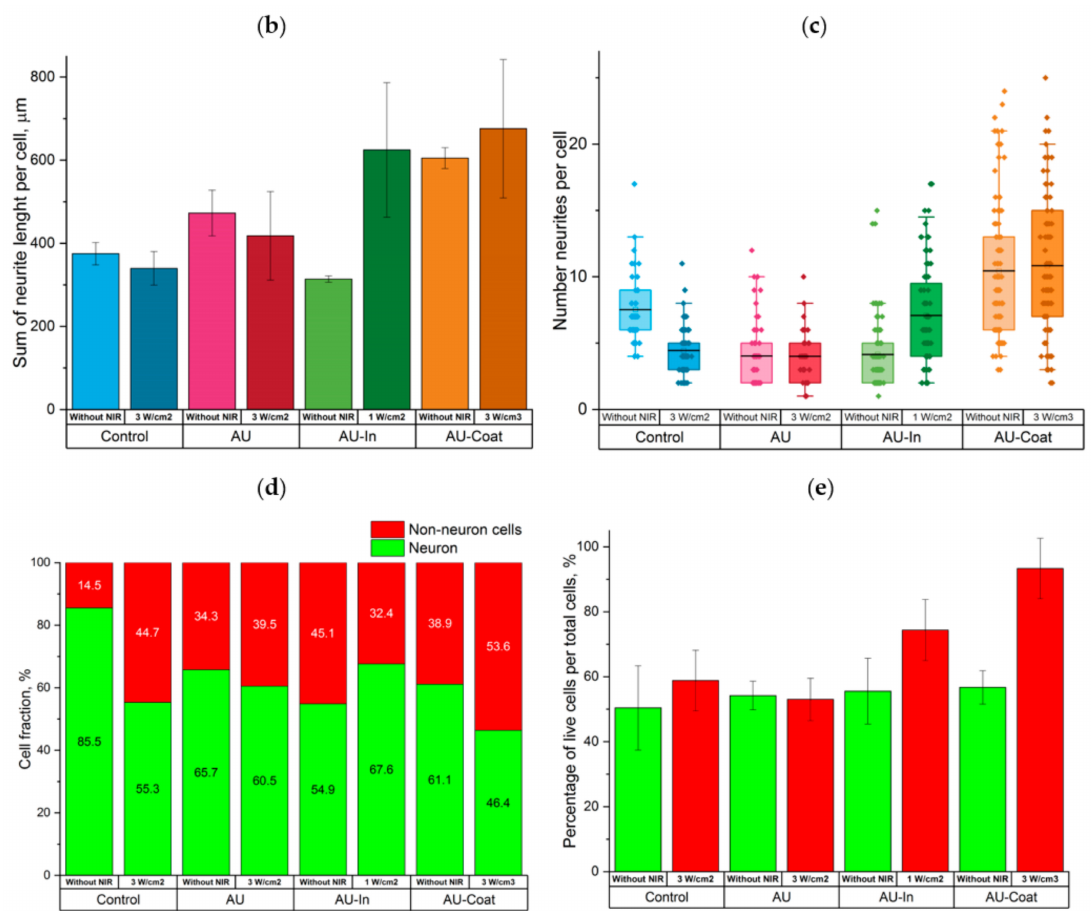
Figure 7. Nanotopology-mediated and photothermal stimulation of neurite outgrowth. Immunoflu- orescence images of neurons on different scaffolds with and without NIR irradiation stained for β 3-tubulin in green, glial fibrillar acidic protein (GFAP) in red and nuclei in blue. The arrows show the direction of fiber orientation. Scale bar—50 µ m ( a ). Comparison of the total elongation of neurites per cell ( b ), number of neurites per neuron ( c ), fraction of β 3-tubulin-positive (neuron) cells ( d ), and percentage of live cells per total cell population ( e